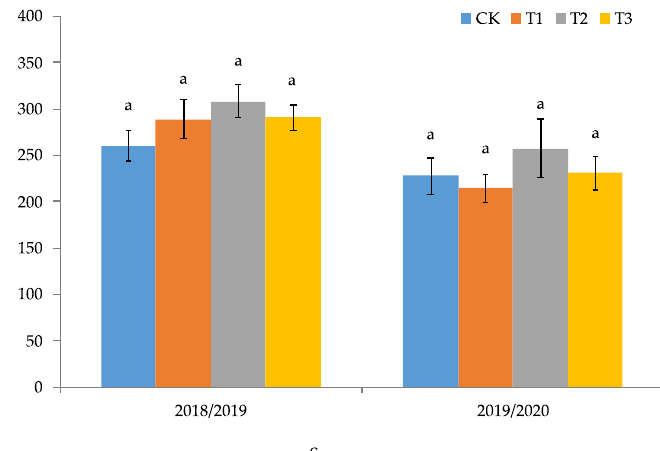
Figure 4. Effect of different doses of compost on stomatal conductance (mmol m − 2 s − 1 ) of the calafate leaf ( Berberis mycrophilla G. Forst) for the 2018–2019 and 2019–2020 seasons. CK = Control treatment (without compost application); T1 = Treatment 1 (5 Ton ha − 1 ); T2 = Treatment 2 (10 Ton ha − 1 ); T3 = Treatment 3 (15 Ton ha − 1 ). For each treatment, different lowercase letters indicate significant differences in both seasons according to Fischer’s LSD test ( p < 0.05). The bars correspond to the experimental error of each